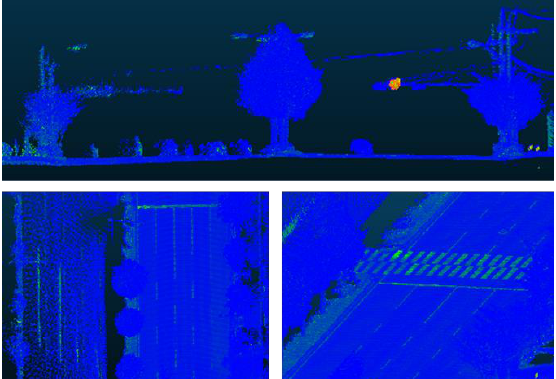
Figure 6. Visualization of the georeferenced point cloud data